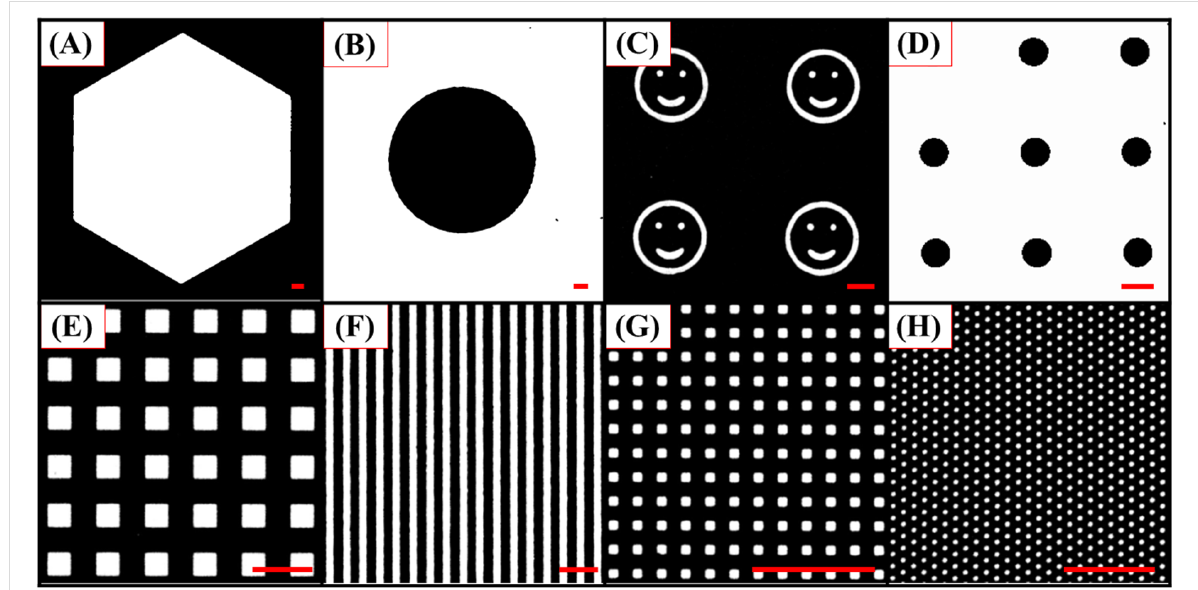
Figure 5: Fluorescence microscopy images (A–H) of FAM-labelled DNA patterned surfaces with various features and sizes created by CLL. The scale bars are 50 μ m.